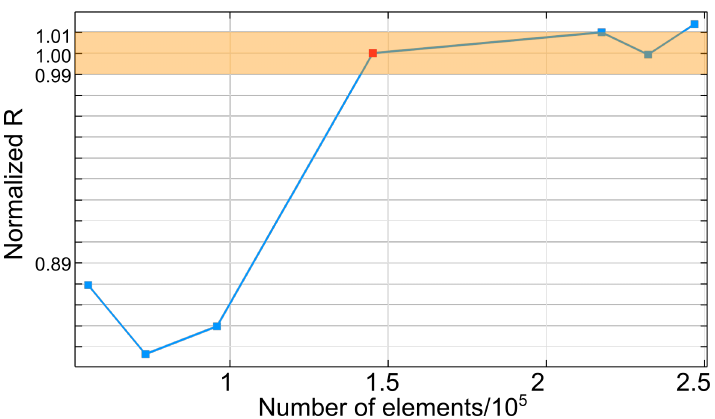
Figure A1. Mesh convergence study of the 3D model. The color highlighted area indicates the deviation range within 1% from the value we obtained using the selected mesh quality in this study (red spot) with the total number of elements